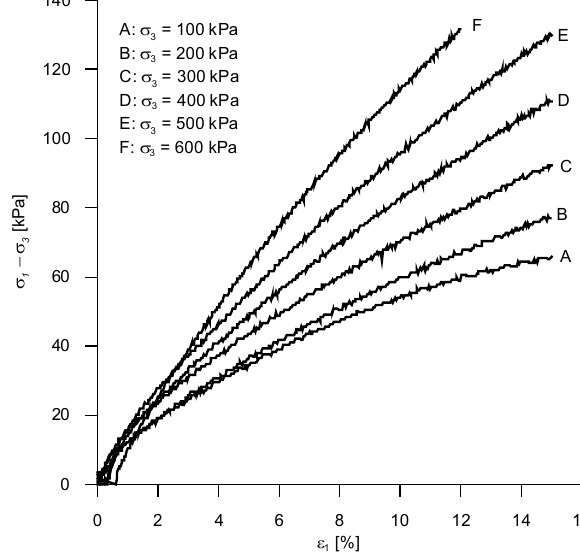
Figure 8: Illustration of the results of strength tests of soil of soft consistency (A-1 and B-1) from one